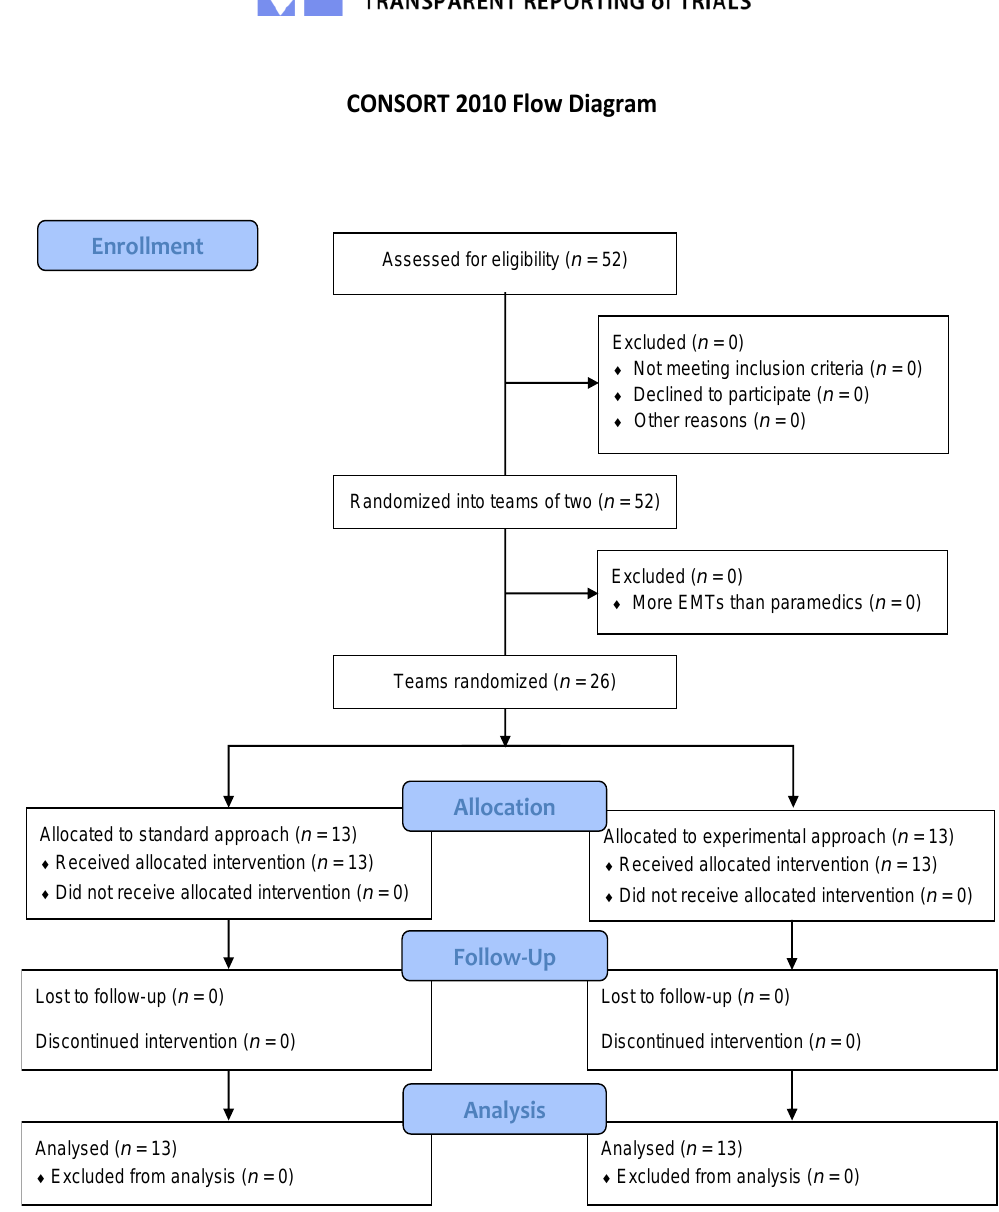
Figure 2. Study flowchart. Figure 2. Study Table 1. Participants ’ characteristics.